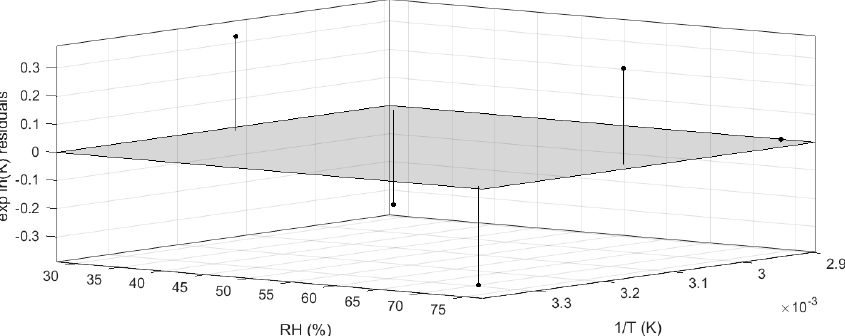
Figure 7. Residual plot generated by Matlab curve-fitting tool.